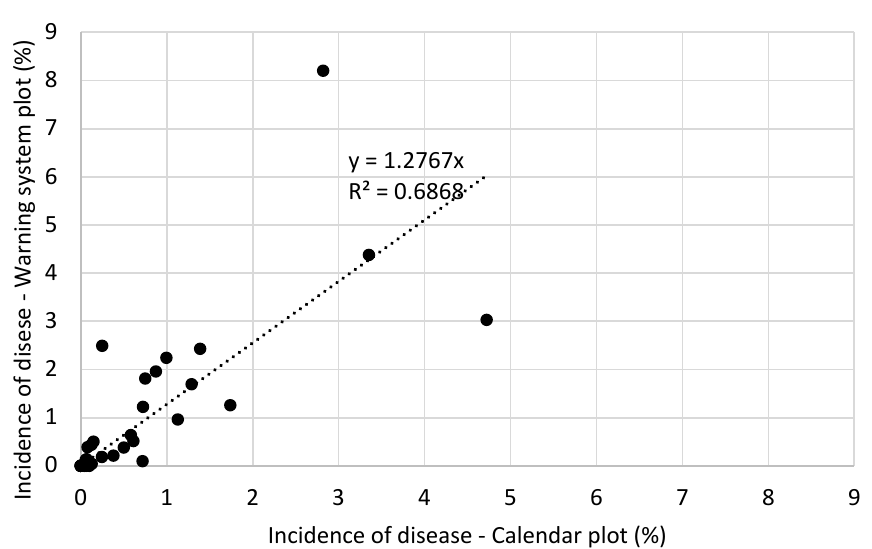
Figure 2. Correlation between the incidence of disease recorded in the field in the warning system and calendar plots plotted in Axis Y and X, respectively. Outliers were not included in the correlation.